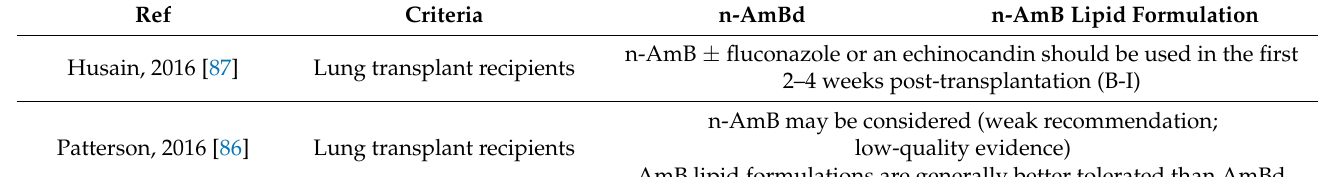
Table 3. Guidelines for prophylactic use of nebulized AmB in lung transplant